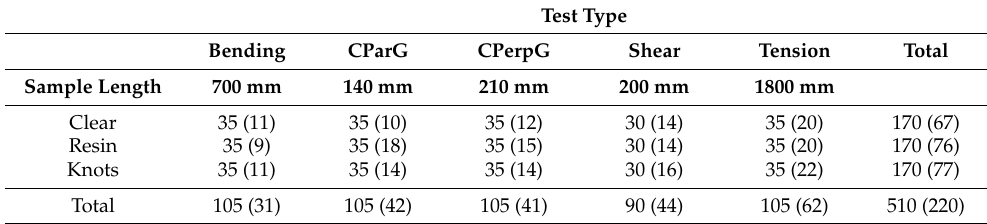
Figure 2. Examples of clear and resin samples and of a typical knot sample. Table 1. Test samples with cross section of 90 × 35